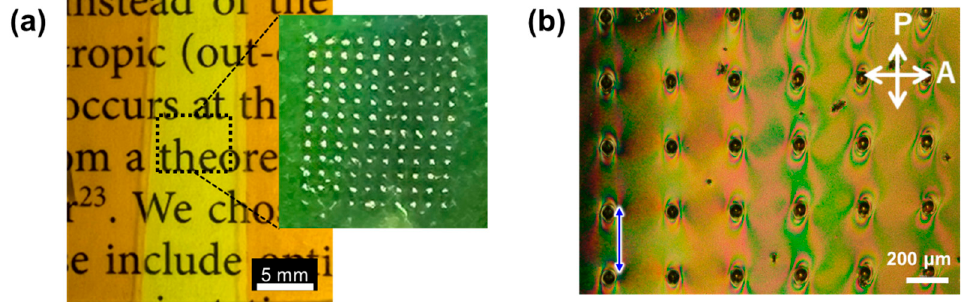
Figure 5. Characterization of the fabricated microlens array. ( a ) Photograph of the LC cell containing the microlens array. ( b ) POM image of the fabricated microlens array. The blue arrow indicates the polarization direction of the 488 nm laser beam used to fabricate the microlens array.